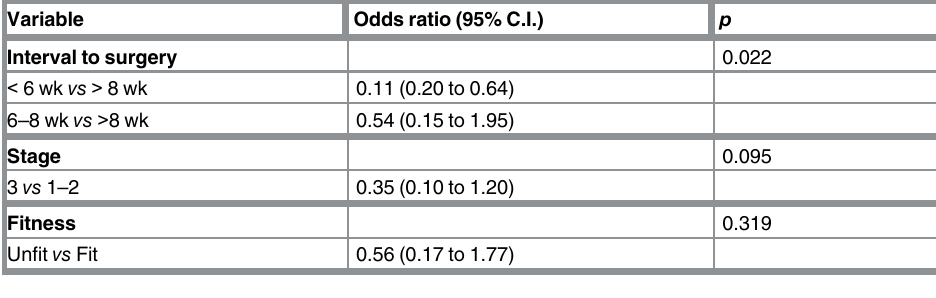
Table 4. Multivariate analysis of the effect of the interval to surgery on Tumor Regression Grade (TRG). Variable Odds ratio (95% C.I.) p Interval to